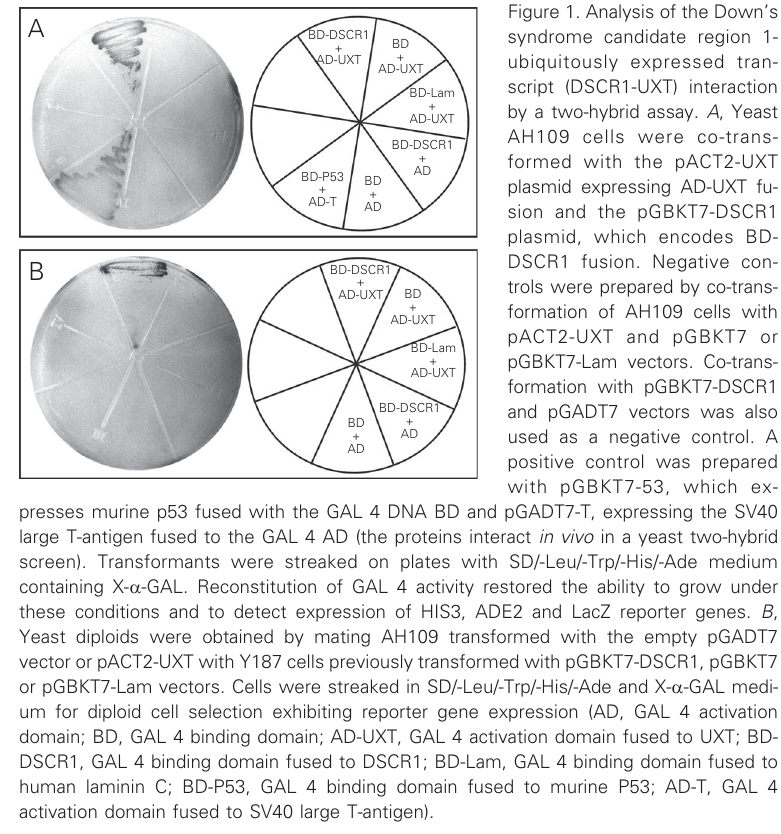
DSCR1, GAL 4 binding domain fused to DSCR1; BD-Lam, GAL 4 binding domain fused to human laminin C; BD-P53, GAL 4 binding domain fused to murine P53; AD-T, GAL 4 activation domain fused to SV40 large